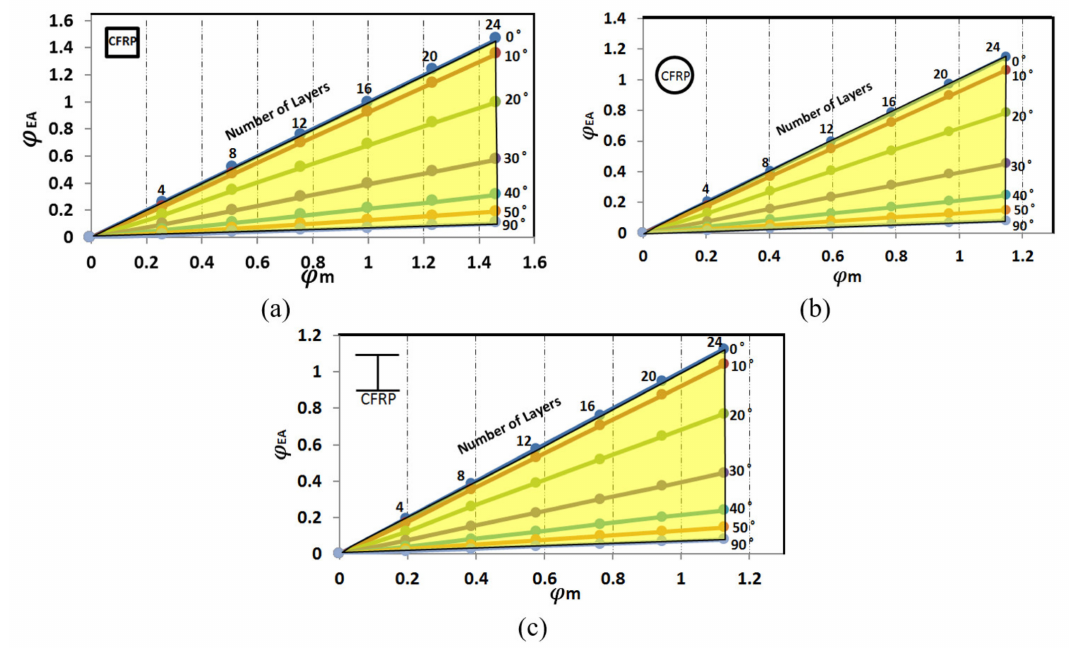
Figure 3. Normalized axial stiffness versus mass ratio index for CFRP materials of construction: ( a ) square beam, ( b ) circular tube, and ( c ) I-beam.